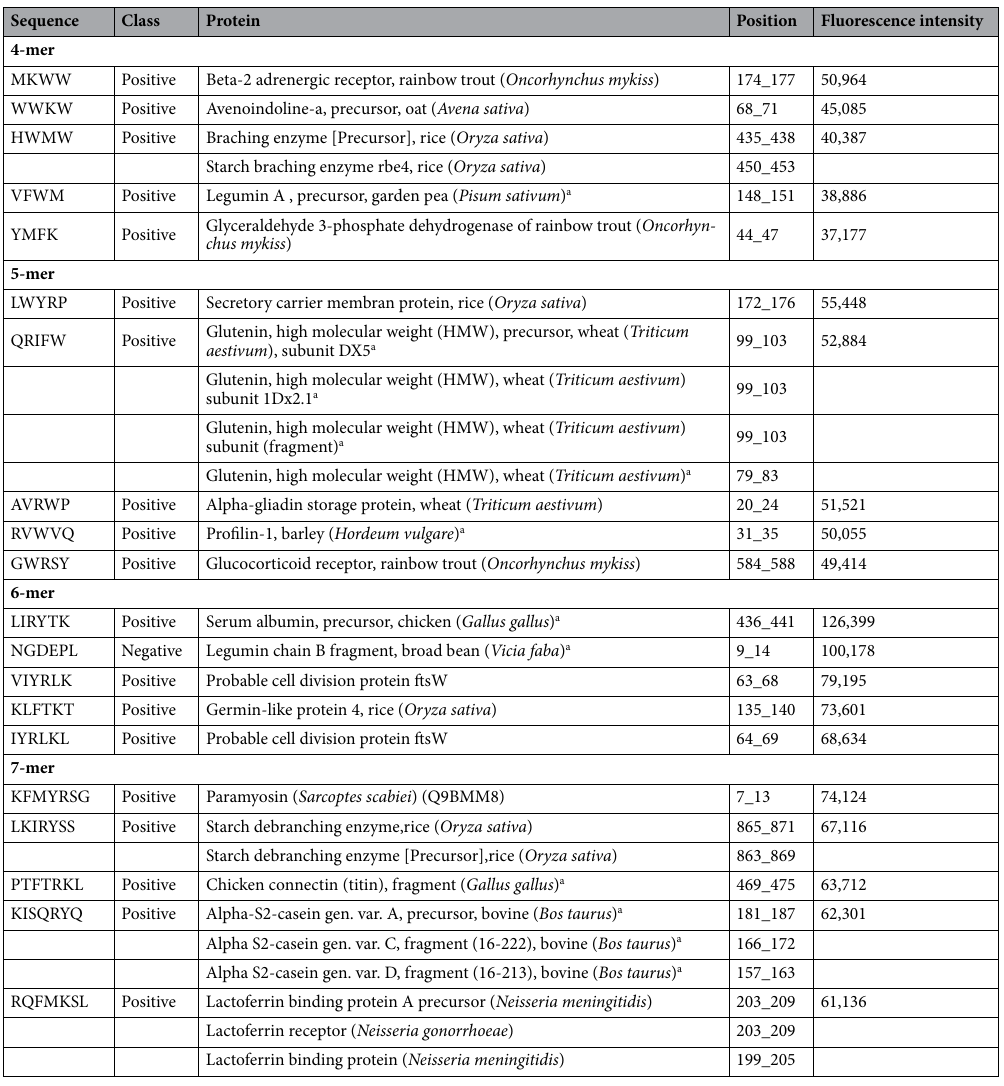
Table 4. The details of the top 5 peptides with the highest probability of having bile acid binding activity. a Storage proteins. Protein refers to the parent proteins and position refers to the site of the peptides from the N-terminus in the BIOPEP-UWM